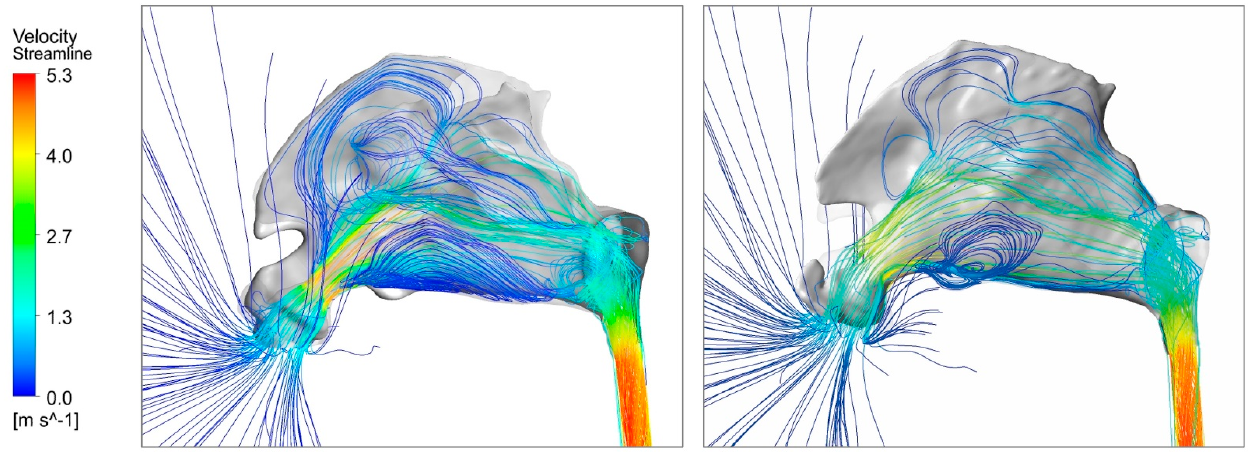
Figure 9. Streamlines comparison of the left ( left hand side pattern ) and right chamber ( right hand side pattern ).